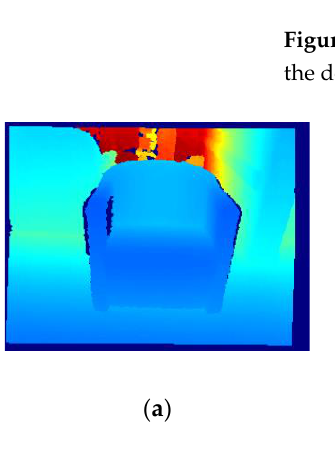
Figure 2. Nearest neighbour terpolation (INTER_NEAREST) results for depth images (PSNR = 29.795 dB). ( a ), depth image; ( b ), front view of the point cloud map of the depth image; ( c ), side view of the point cloud map of the depth image.